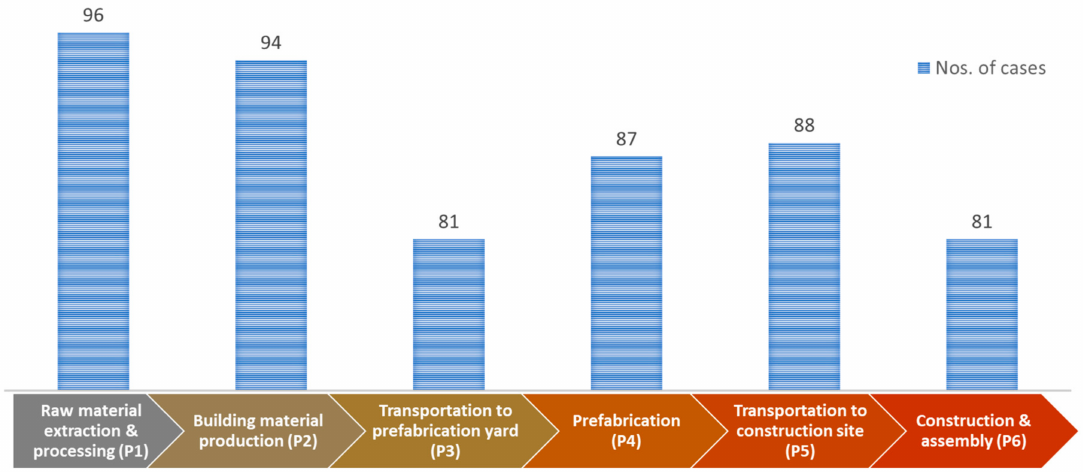
Figure 7. Life cycle phases concerned in the reviewed building